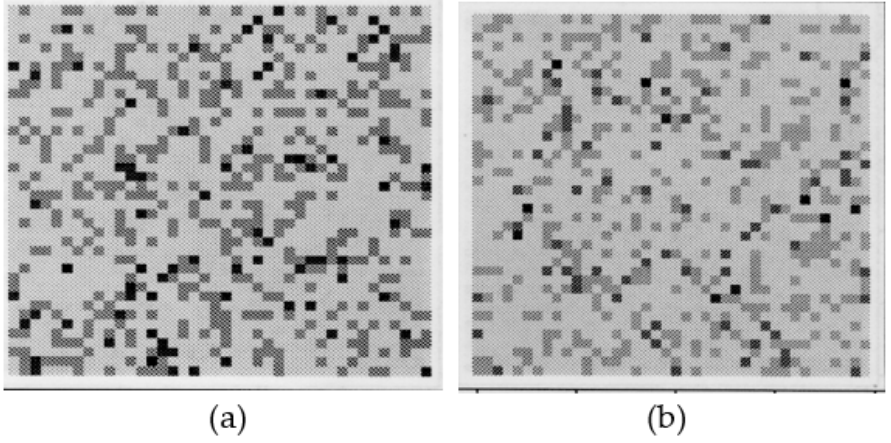
Figure 7. Realizations from auto-Poisson models: ( a ) first-order isotropic; ( b ) second-order isotropic.